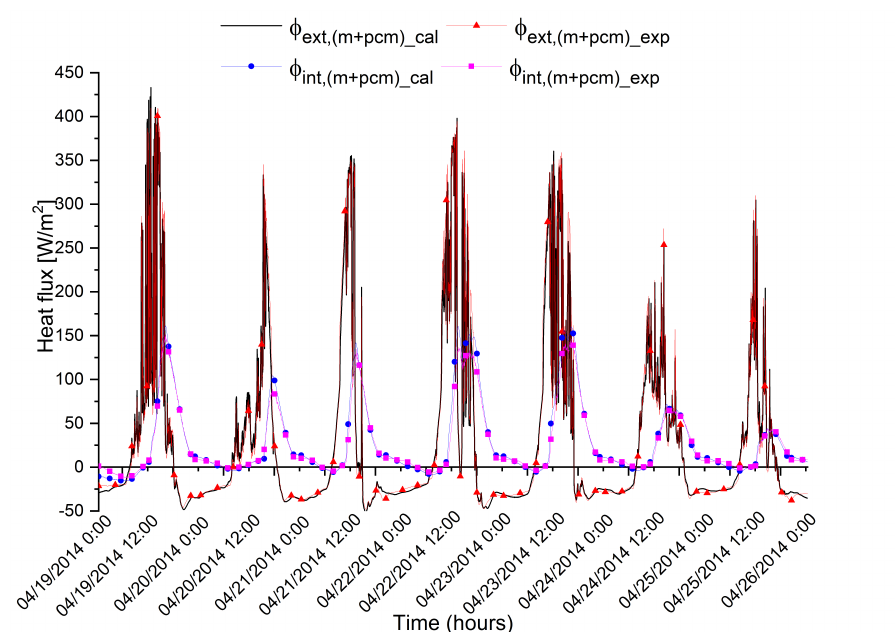
Figure 10. Comparison of heat fluxes on both sides of the storage wall (model results and experimentation). φ ext,(m+pcm)_cal and φ ext,(m+pcm)_exp denote respectively the evolution in numerical and experimental heat fluxes on the exterior surface of the storage wall containing PCM; φ int,(m+pcm)_cal and φ int,(m+pcm)_exp denote respectively the evolution in numerical and experimental heat fluxes on the interior surface of the storage wall containing PCM.